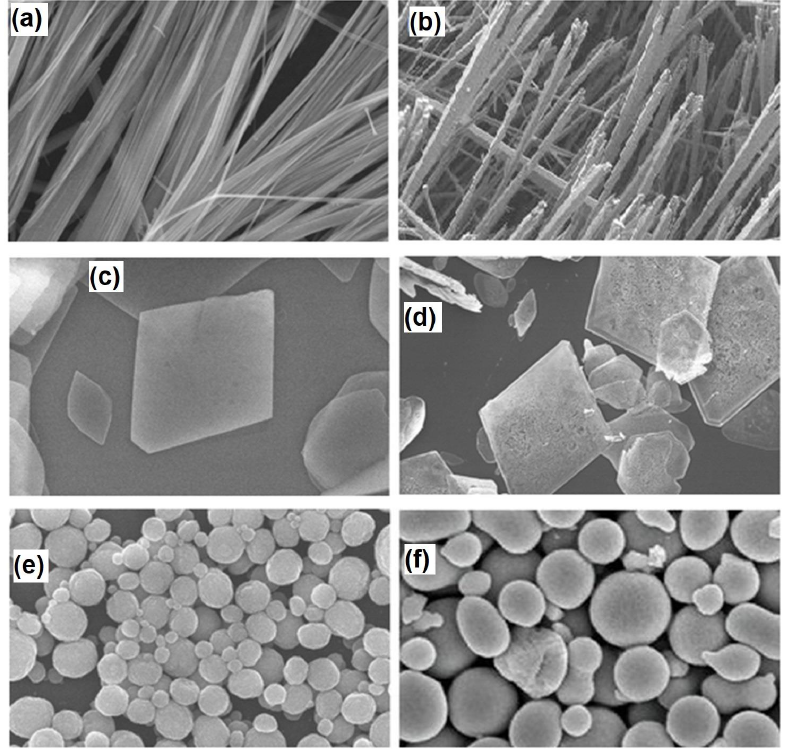
Figure 3. Typical examples of the morphologies of ZnO. ( a , b ) show 1D structures, ( c , d ) show 2D structures, while ( e , f ) show 3D structures. Reproduced with permission from